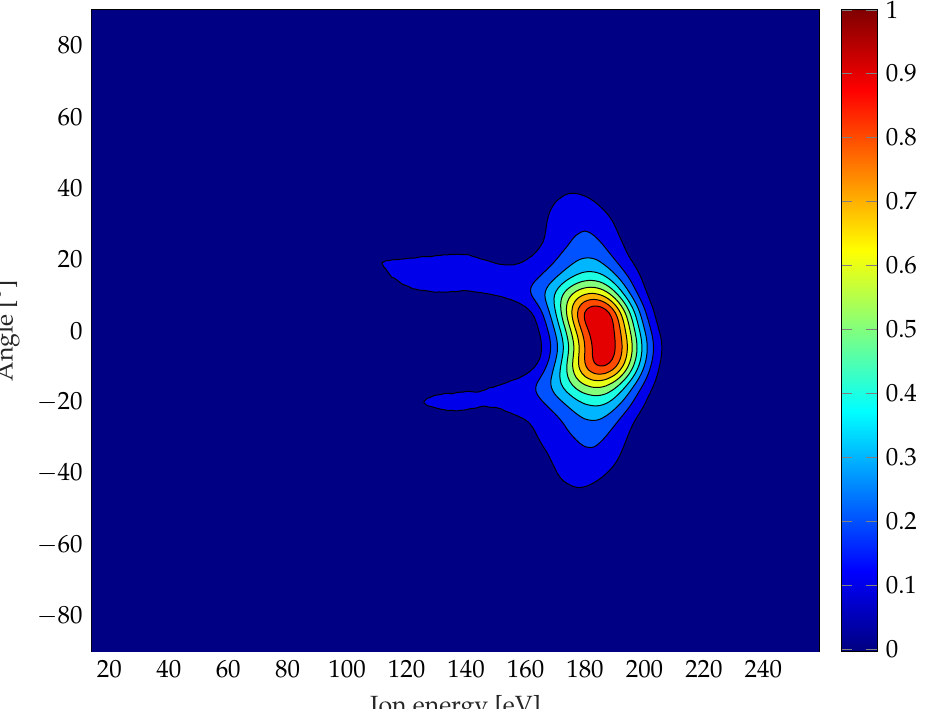
Figure 11. Countour plot of the normalized IEDF as a function of the angle (200 V, 5